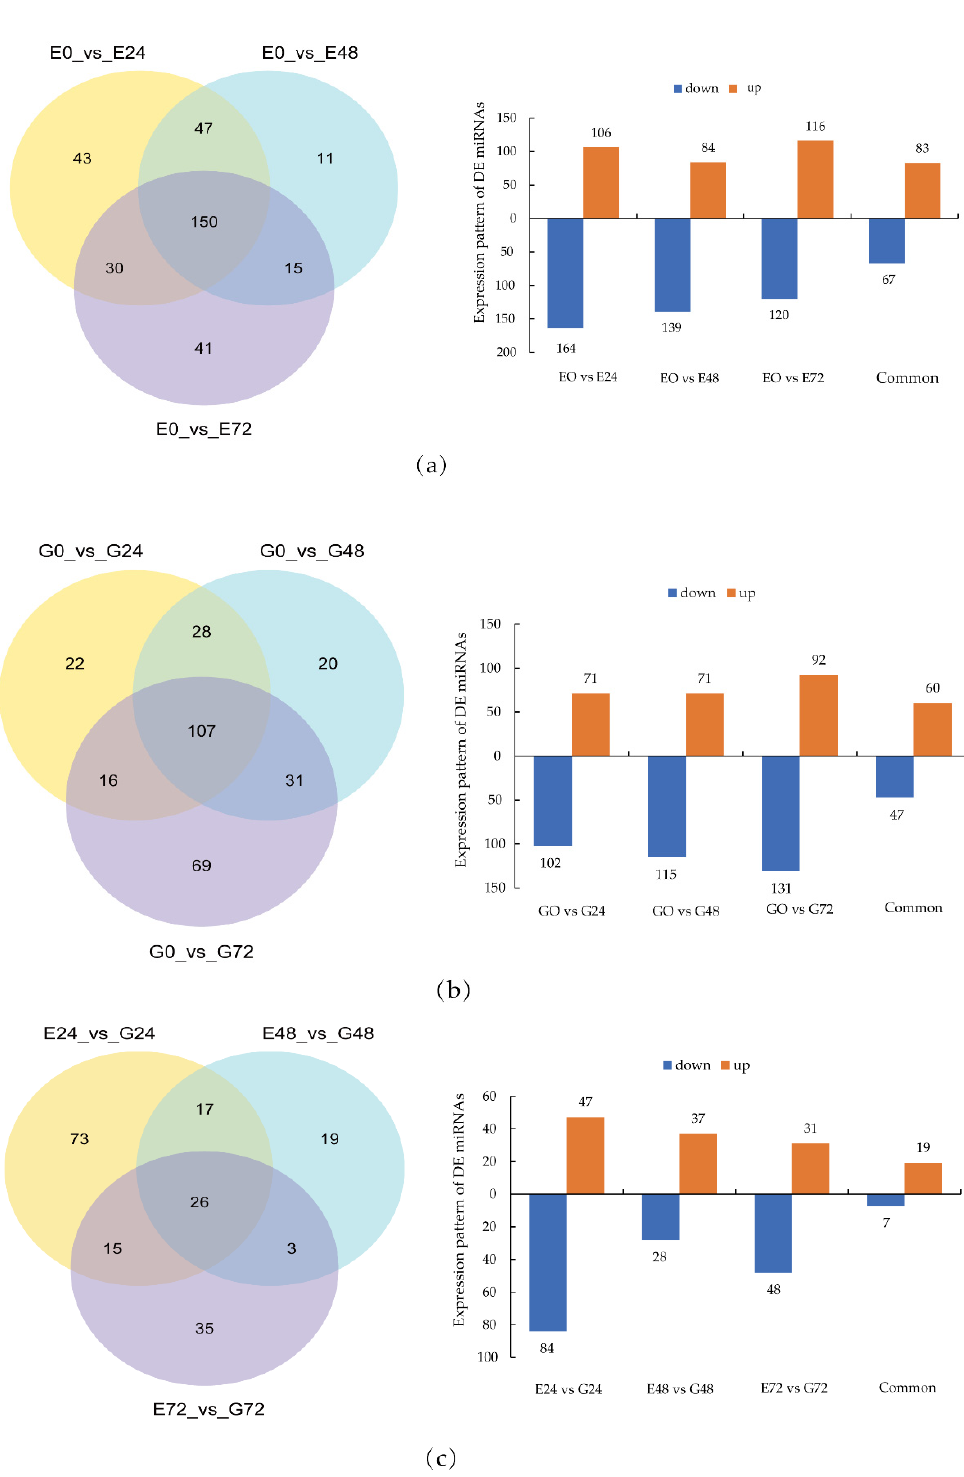
Figure 3. Differentially expressed miRNAs in sweet potato after infection with sweet potato weevils. ( a ) Left : changes in miRNA expression in Eshu 6 tubers after infection with sweet potato weevils; right : expression pattern of DE miRNAs; ( b ) left : changes in miRNA expression in Gaung 87 tubers after infection with sweet potato weevils; right : expression pattern of DE miRNAs; ( c ) left : common differentially expressed miRNAs in Eshu 6 and Guang 87 tubers under different time treatments; right : expression pattern of DE miRNAs.